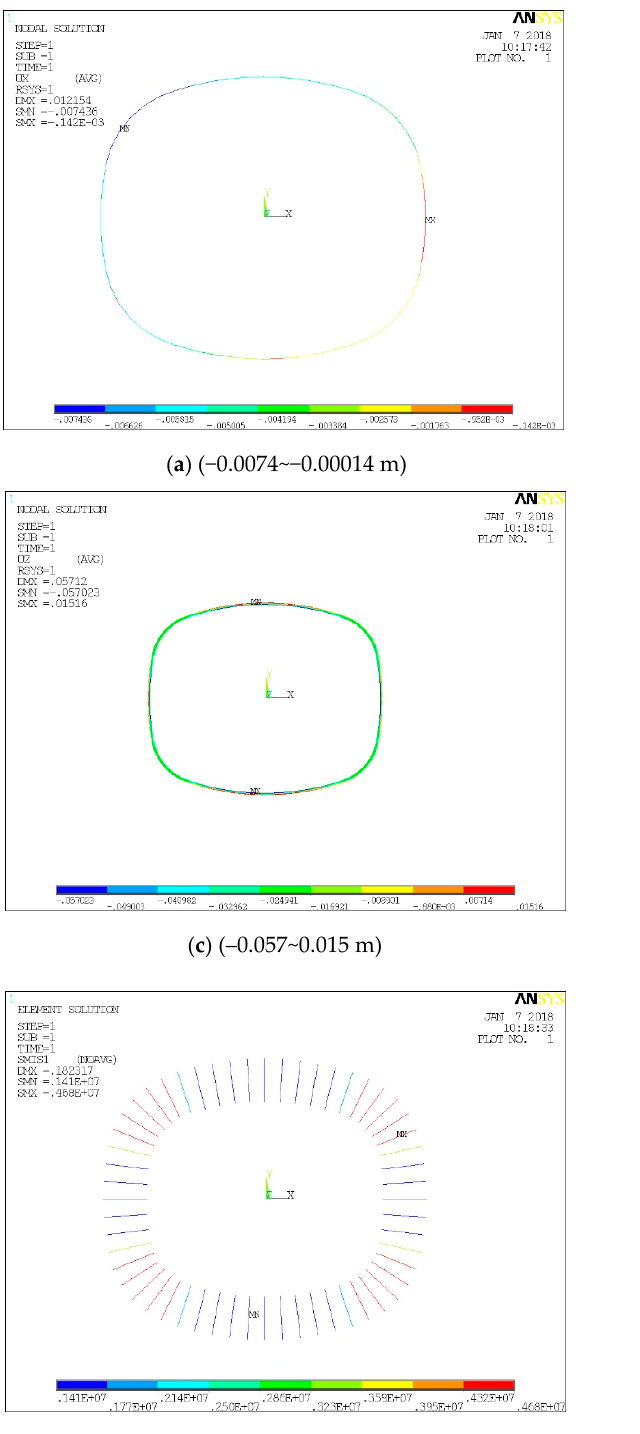
tension ring (m); ( c ) vertical displacement of tension ring (m); ( d ) equivalent stress of CR (Pa); ( e )